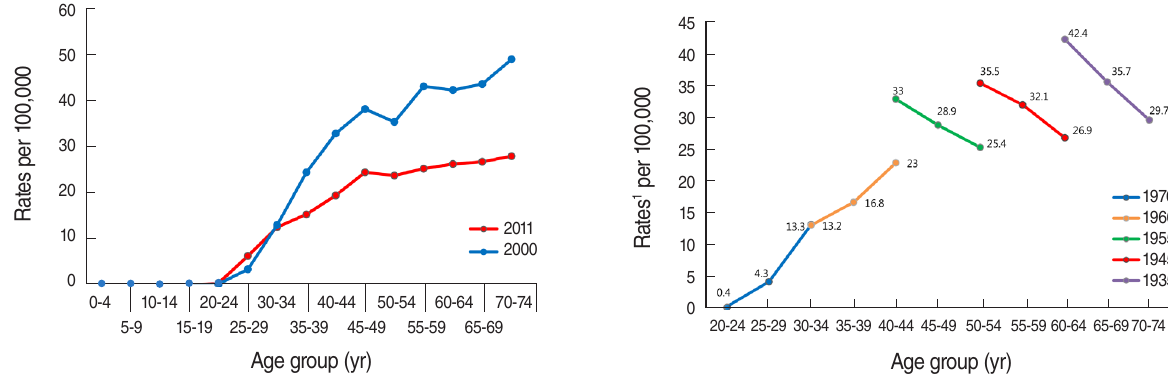
Figure 1. Age-specific incidence rates per 100,000 populations of cervical cancer in Korea, 2000 and 2011. Source from Korean Sta- tistical Information Service. Number of cancer patients, relative fre- quency, crude rate, age-adjusted incidence by cancer site and sex from 1999 to 2011; 2014